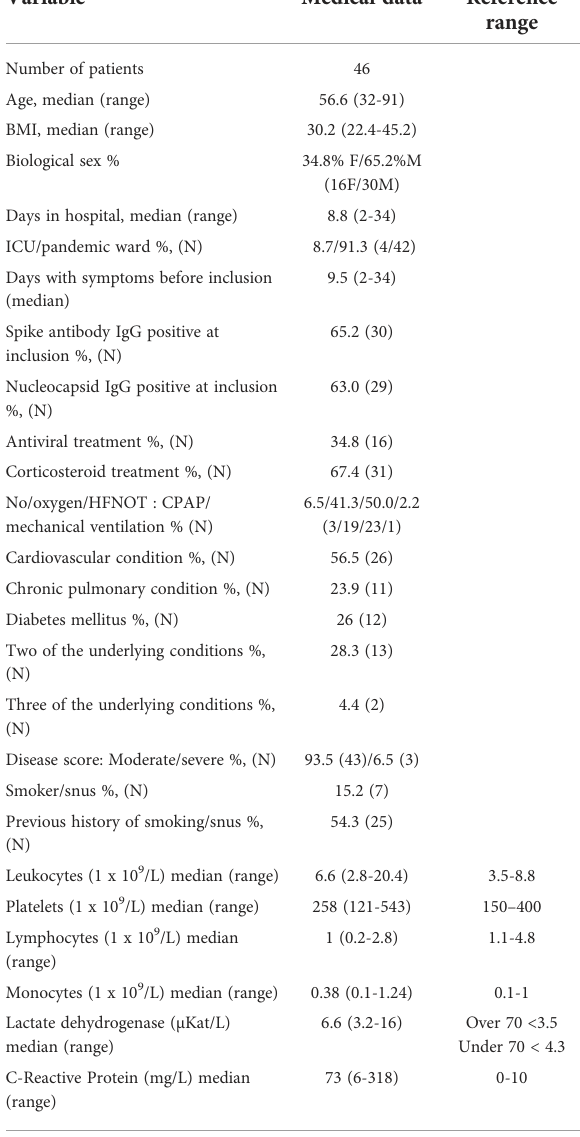
TABLE 1 Clinical and-demographical characteristics of hospitalized COVID-19 patients. .